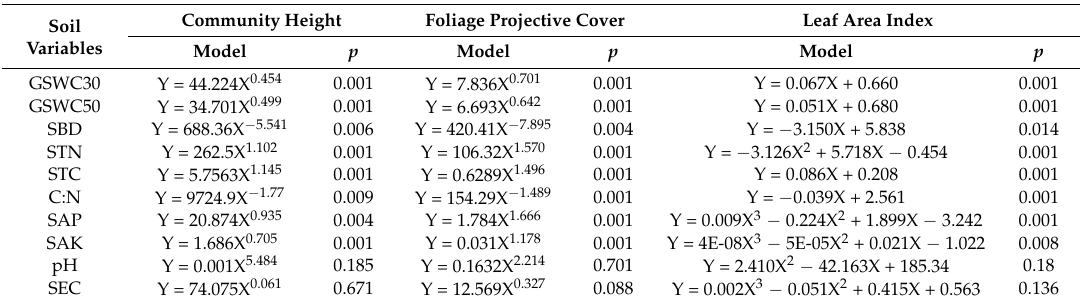
Table A2. Regression equations of community height, foliage projective cover, leaf area index and soil properties. Other abbreviations are given in Table A1.